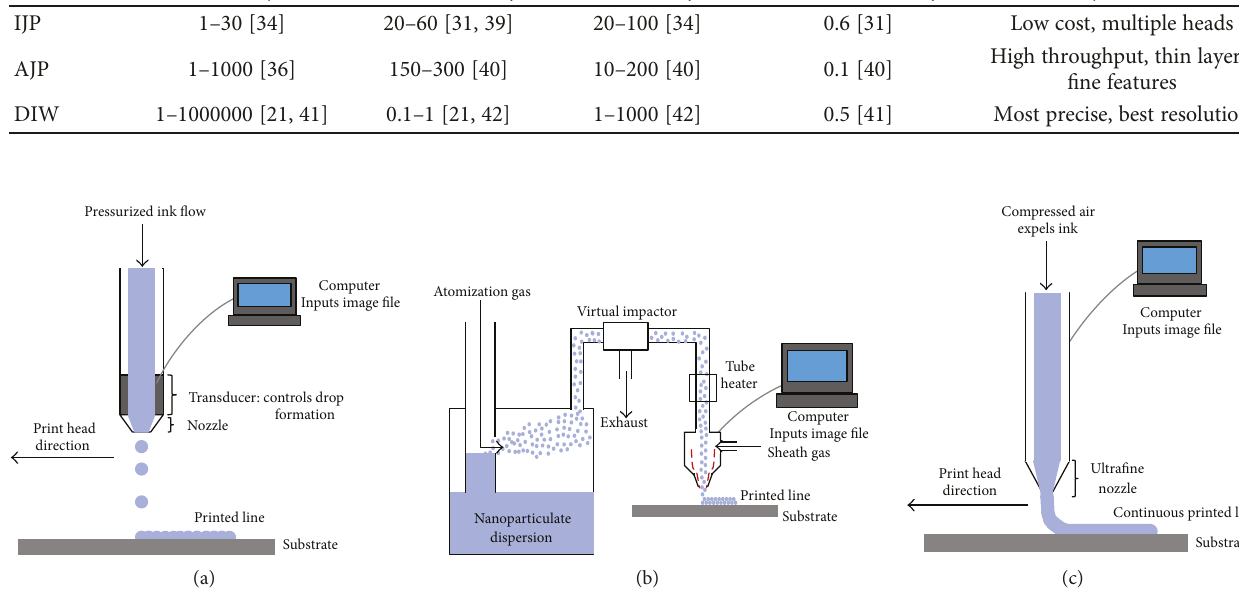
Figure 2: Schematic representation of direct write (DW) printing methods. (a) Inkjet printing (IJP); (b) aerosol jet printing (AJP). Reproduced with permission from [37]. (c) Direct ink writing (DIW).